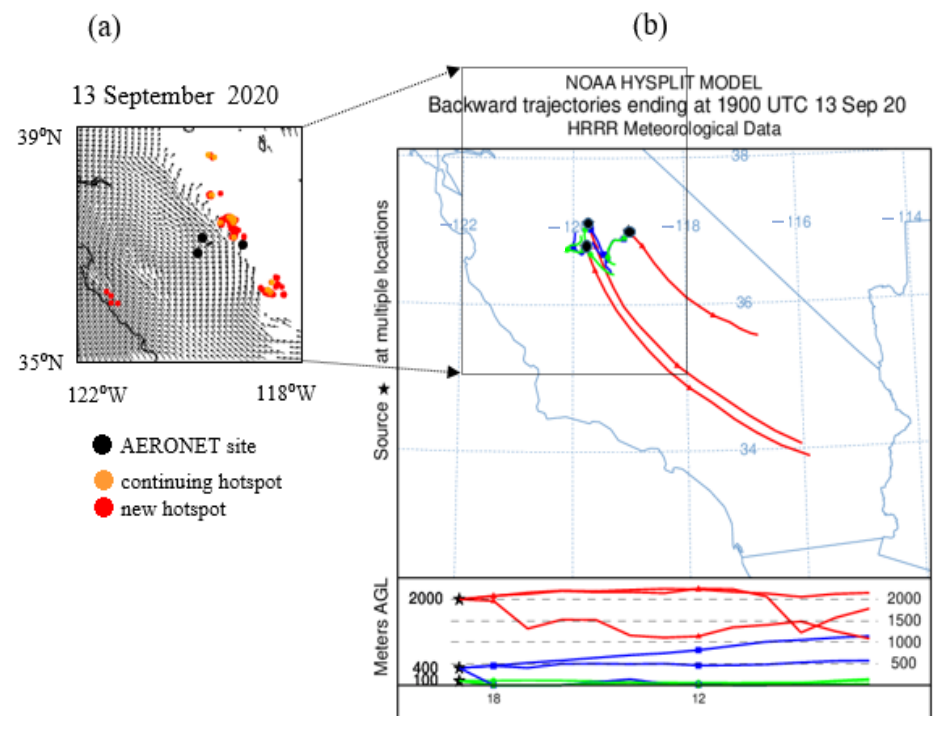
Figure 12. ( a ) Wind behavior at an altitude of 850 hPa during the satellite passing time over Area-S, simulated using a regional SCALE model at 19:00 (UTC) on 13 September 2020 (resolution of 5 km × 5 km). Hot-spot data were derived from Terra/MODIS/MOD14. The orange hot spots represent continuing wildfires. The red hot spots represent new wildfires. The black dots denote the three AERONET observation sites. ( b ) Analysis of the airflow back trajectory of pollutants using an NOAA Hybrid Single-Particle Lagrangian Integrated Trajectory (HYSPLIT) model at 19:00 (UTC) on 13 September 2020. Airflows at heights of 100 m (green line), 400 m (blue line), and 2000 m (red line) correspond to the altitudes of the three AERONET sites in Area-S.